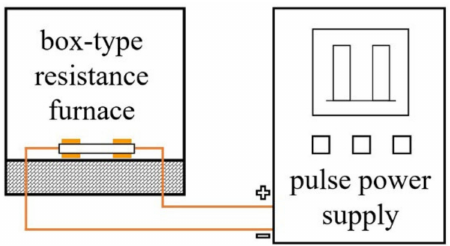
Figure 1. Schematic diagram of electric pulse assisted aging